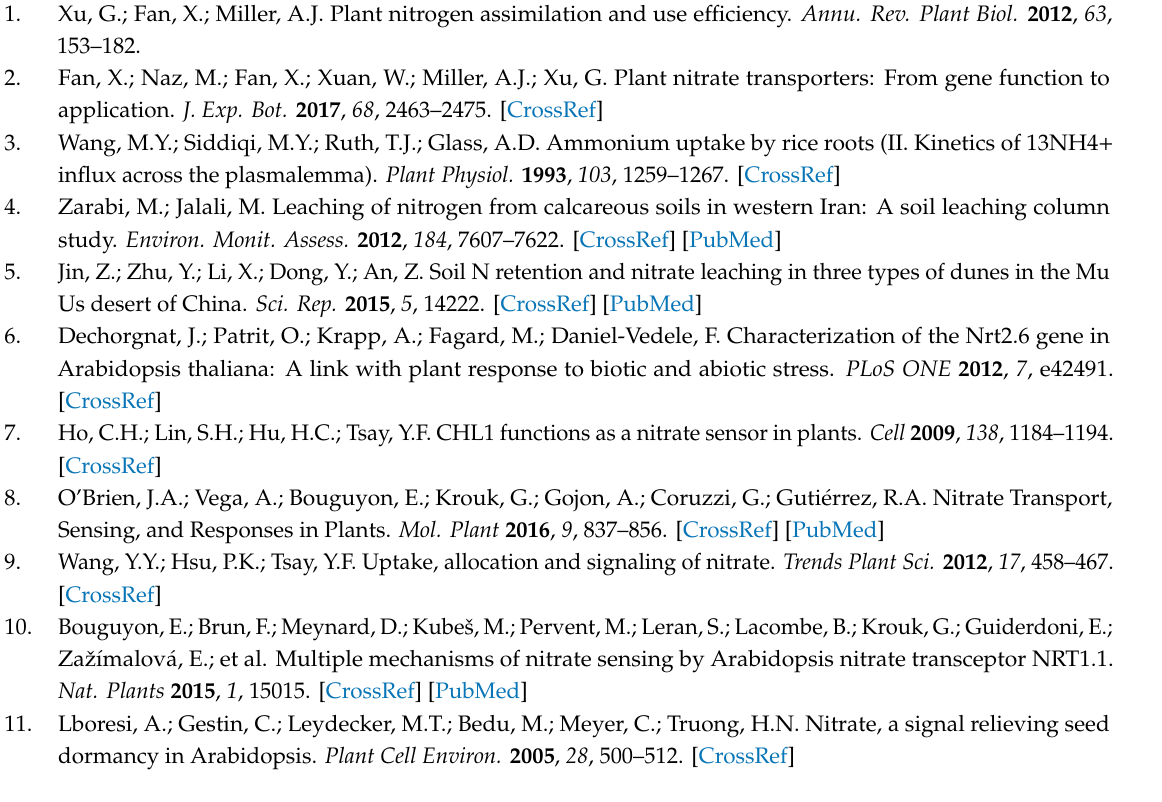
Table S1. Primers used for qRT-PCR, Table S2. The average data statistics of the 15 NO 3 − influx rate in roots of WT and OsNRT2.1 transgenic lines under 0.5-mM 15 NO 3 − conditions with NPA and without NPA, Figure S1. Rice seed size, Figure S2. Plant growth of WT and OsNRT2.1 transgenic lines under 0.5-mM NH 4 + or NO 3 − conditions, Figure S3. The expressions of OsPINs in the roots of WT and OsNRT2.1 transgenic lines under 0.5-mM NO 3 − conditions with NPA treatment, Figure S4. 15 NO 3 − influx rate in roots of WT and OsNRT2.1 transgenic lines under 0.5-mM 15 NO 3 − conditions, Figure S5. E ff ects of NPA on root growth under 0.5-mM NH 4 + or 0.5 mM NO 3 −